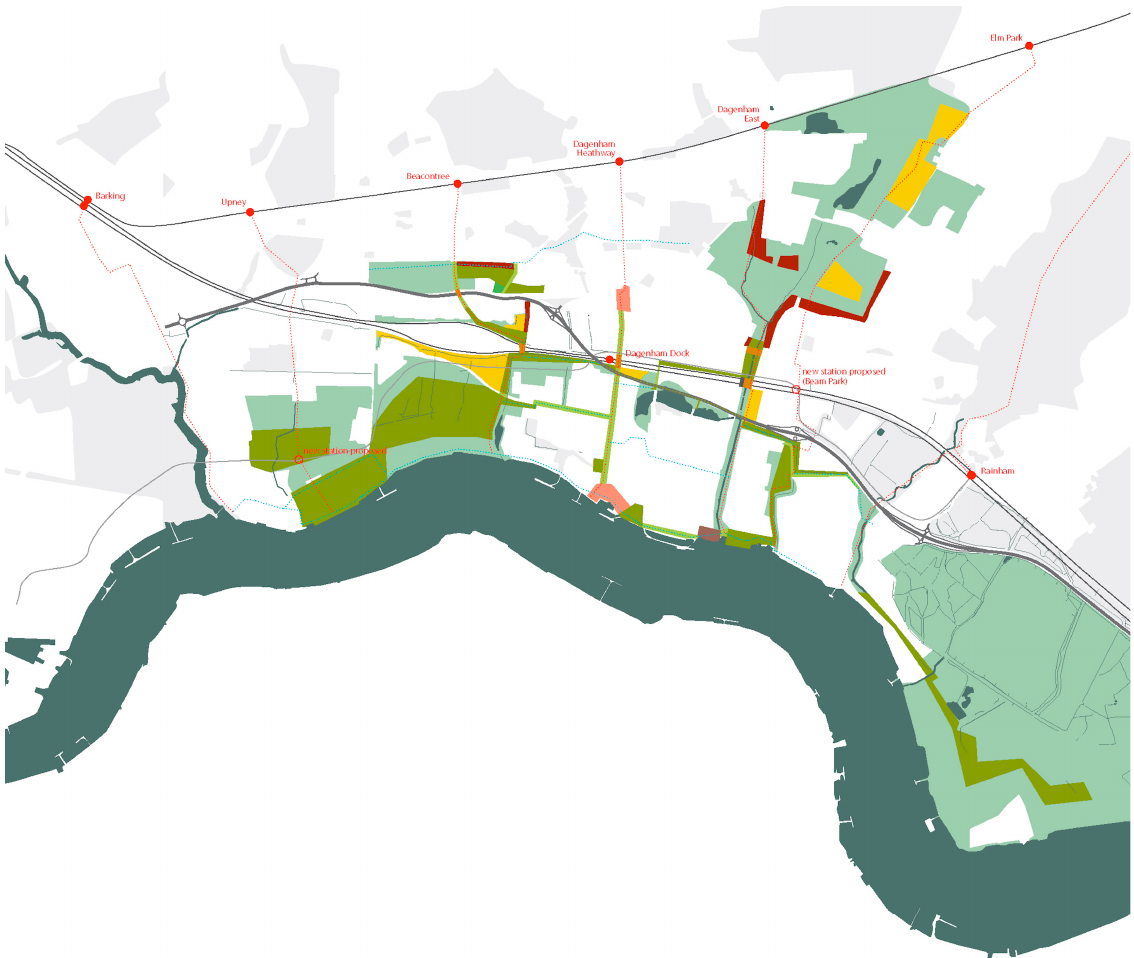
Figure 3. Bohn and Viljoen’s Continuous Productive Urban Landscape concept, as illustrated in their Thames Gateway proposal. Image courtesy of Bohn & Viljoen Architects.